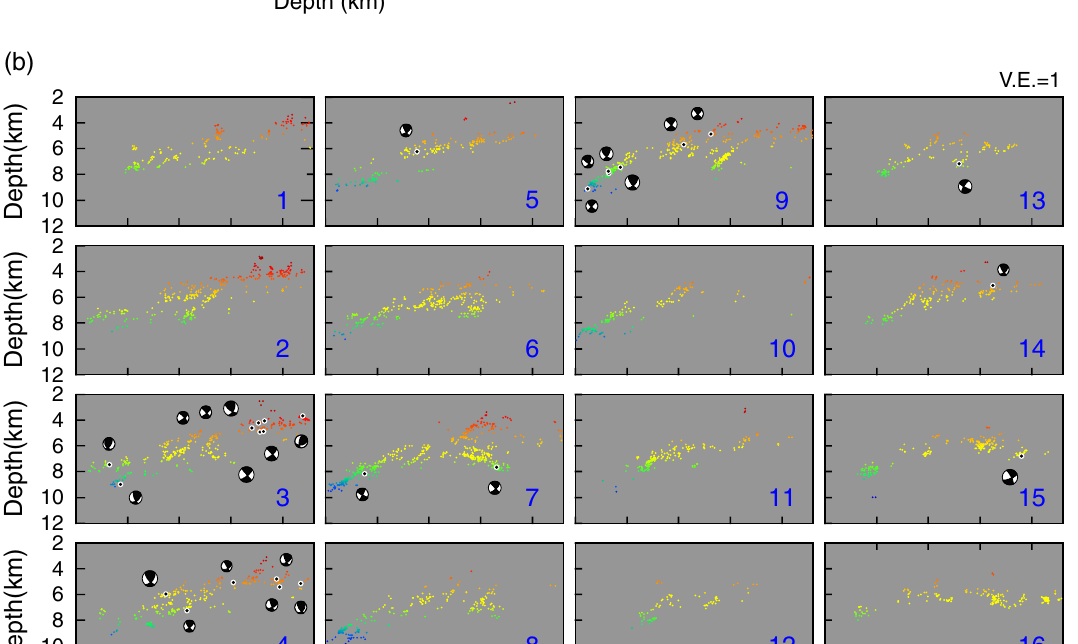
Fig. 8 a Distribution of the hypocenters that were relocated using waveform-derived differential time data. Focal depths are color-coded. The map location is indicated on the inset map. b E–W vertical cross sections of the hypocenters. The focal mechanism solutions of the M that are reported in the JMA catalogue are shown. Profiles are spaced at a 0.01° (~ 1.1 km) interval, and the earthquakes in each profile do not appear in the adjacent